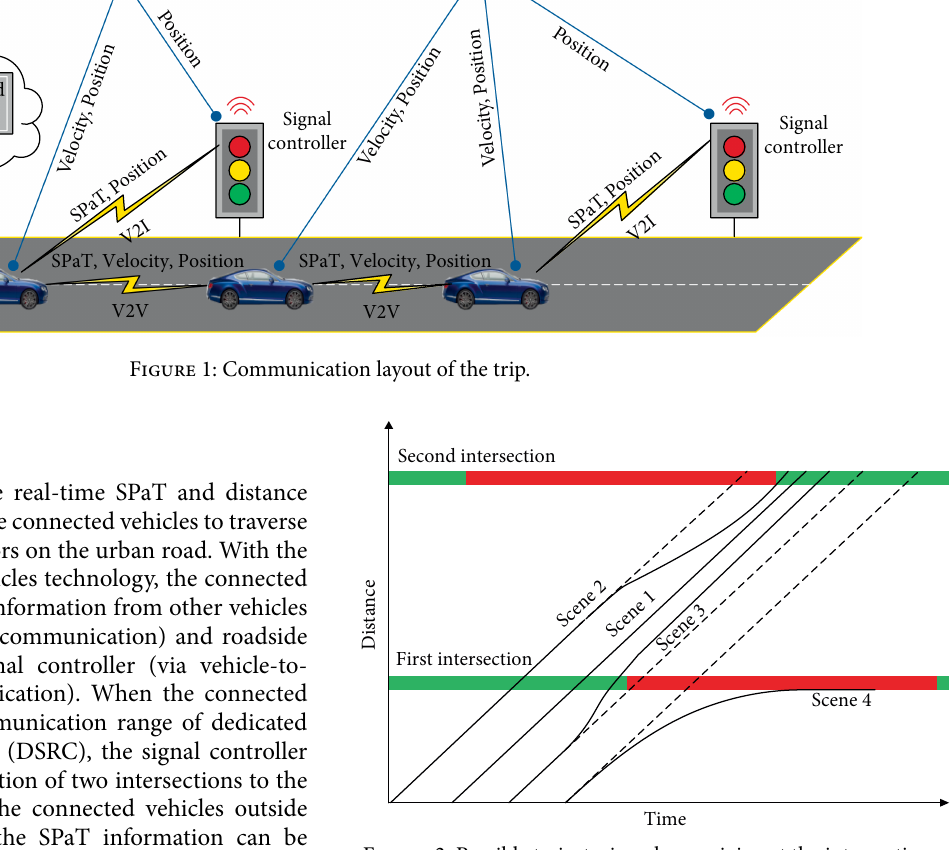
Figure 2: Possible trajectories when arriving at the